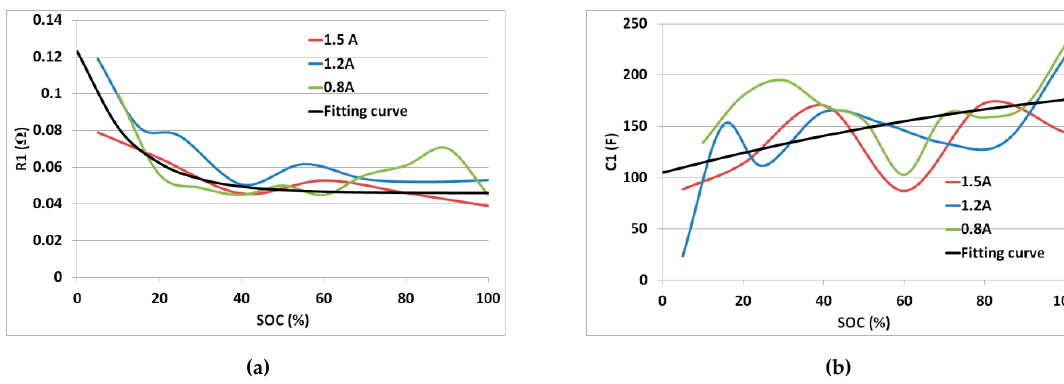
Figure 6. Values of activation parameters versus SOC for different discharge currents ( a ) resistance R 1